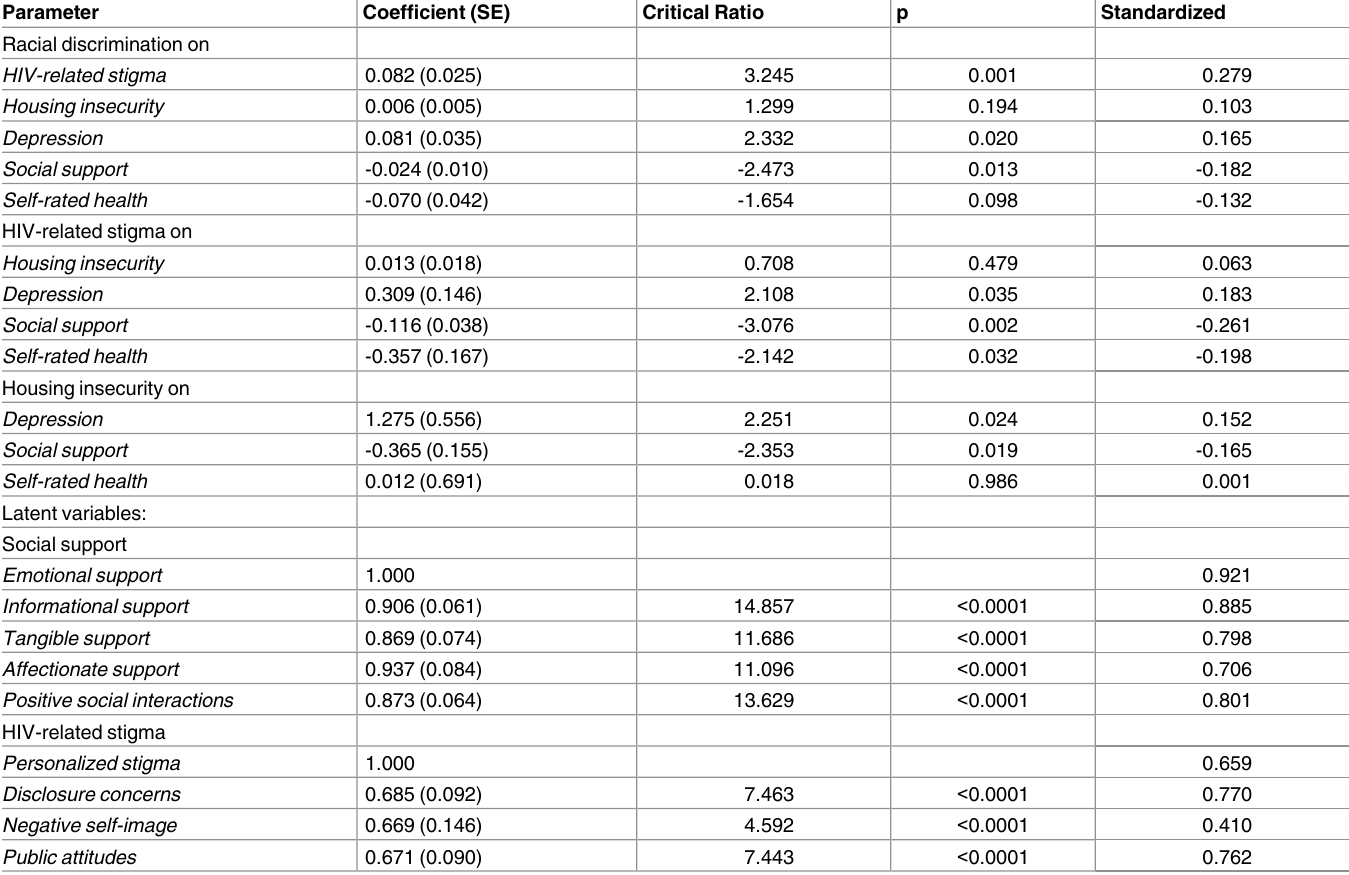
Table 3. Parameter Estimates for Final Path Model in African and Caribbean Black Women’s Stigma and Health Study: Ontario, Canada, 2011 (n =